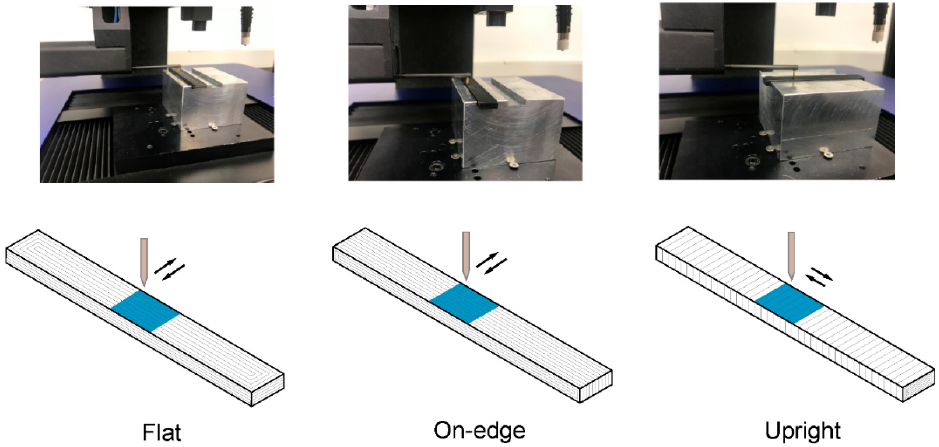
Figure 10. Surfaces texture measurements for the different build orientations.